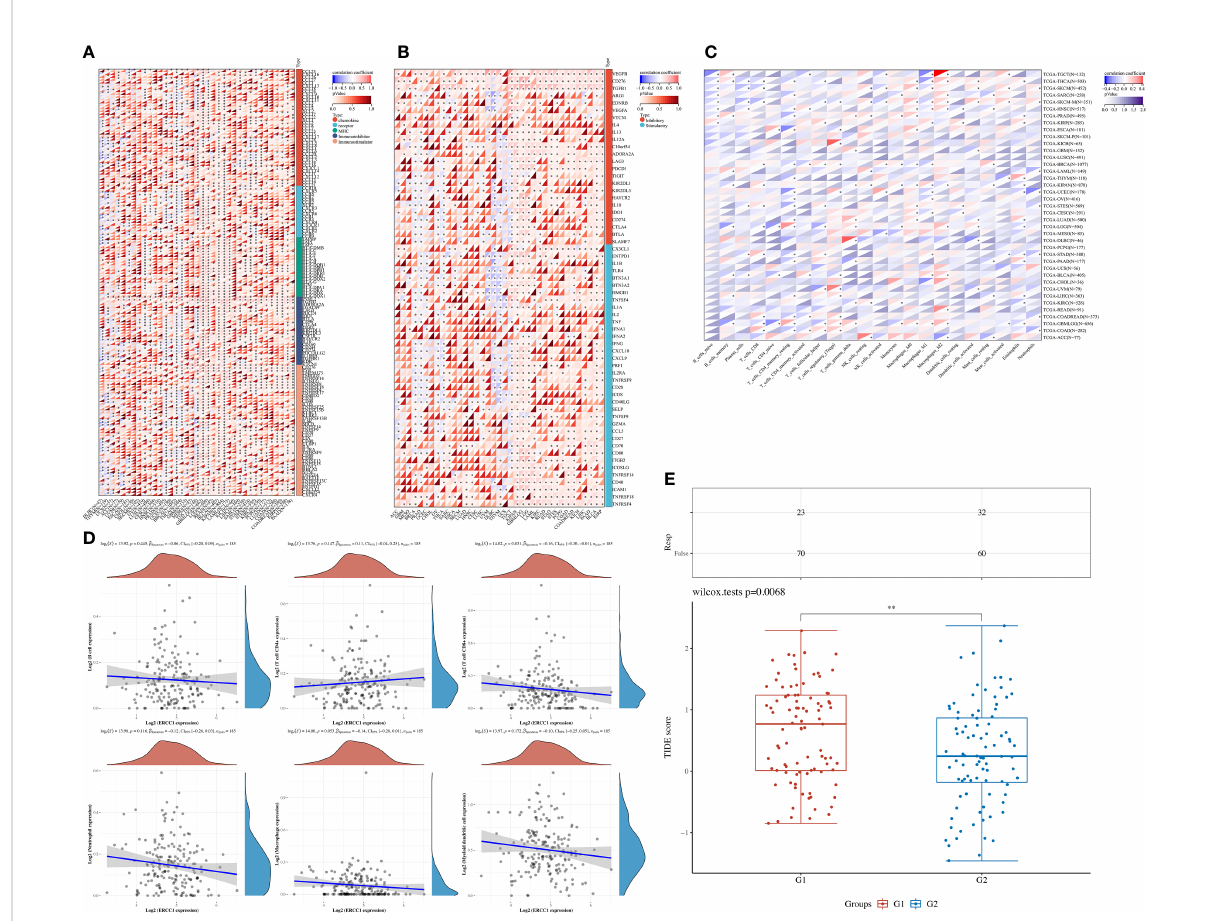
FIGURE 3 The effect of ERCC1 on immune status. (A) Correlation between ERCC1 and 150 immune pathways marker-related genes in pan-cancers. (B) Correlation between ERCC1 and immune checkpoints in pan-cancers. (C) The correlation between ERCC1 and tumor-associated immune cells was evaluated using Cell-type Identi fi cation by Estimating Relative Subsets of RNA Transcripts in pan-cancers. (D) Correlation between ERCC1 and tumor-associated immune cells in HER2 over-expressing breast cancer. (E) Tumor immune dysfunction and exclusion score in HER2 over-expressing breast cancer. G1: High expression of ERCC1. G2: Low expression of ERCC1 (Divided by average expression). *P < 0.05; **P < 0.01; ***P < 0.005; ****P <